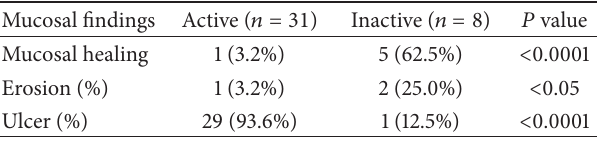
Table 2: Mucosal findings of the two study groups (univariate